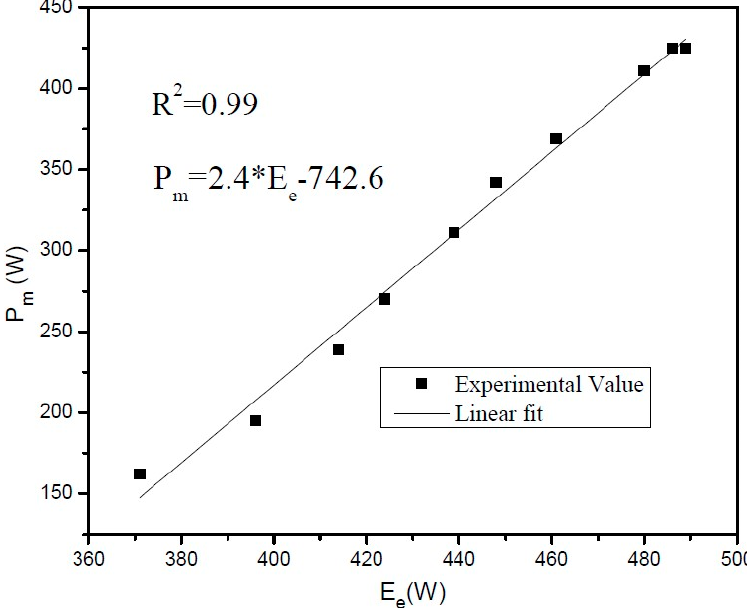
Figure 5. Relationship between electrical energy ( E e ) and mechanical cutting power ( P m